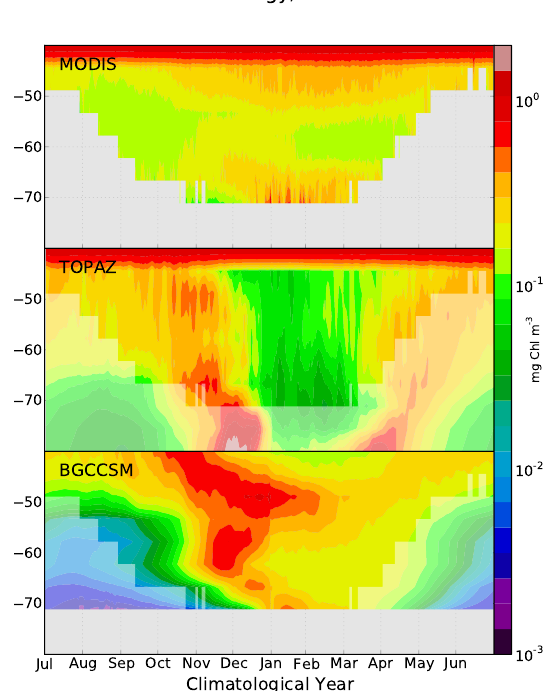
Figure 5. Hofmøller plots of satellite Chl (top panel), Chl simulated by TOPAZ (middle panel), and Chl simulated by BGCCSM (bottom panel) south of New Zealand. All panels are zonal medians within the box. All data that fall on a specific grid cell on a specific day of the year are averaged to one